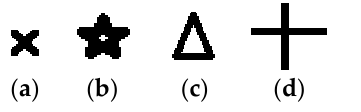
Figure 8. Watermarks used ( a ) 16 × 16 bits ( b ) 32 × 32 bits ( c ) 41 × 41bits ( d ) 45 × 45 bits.